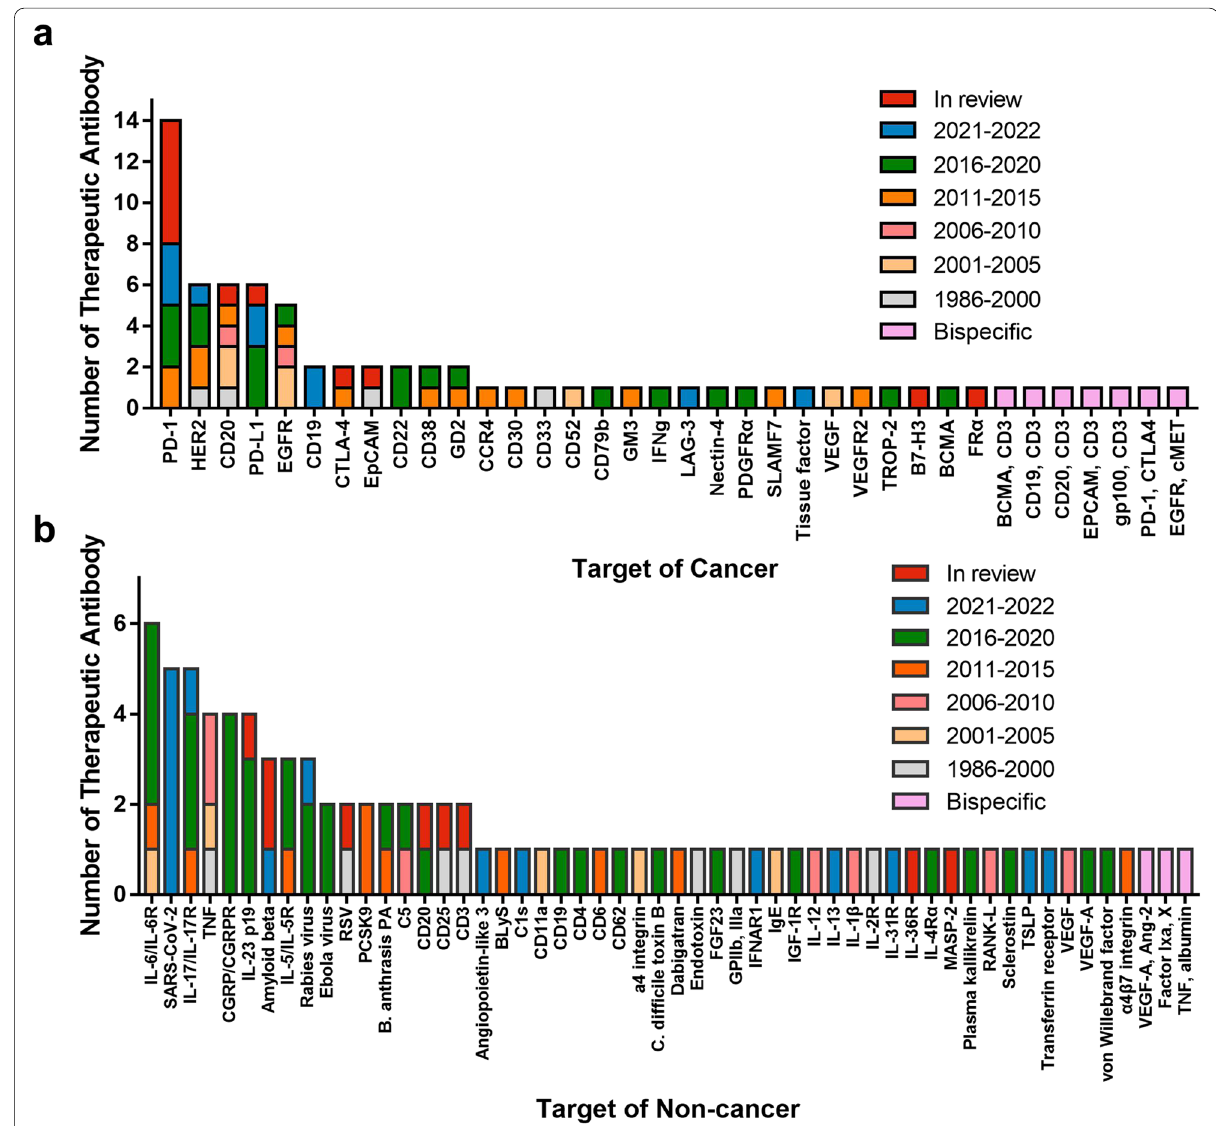
Fig. 2 Targets for antibody therapeutics approved or in regulatory review globally for diseases. a targets for cancer and b targets for non-cancer. TSLP, thymic stromal lymphopoietin. Figure based on data publicly available (www. antib odyso ciety. org/ antib ody- thera peuti cs- produ ct- data/.) as of July 1, 2022, total =